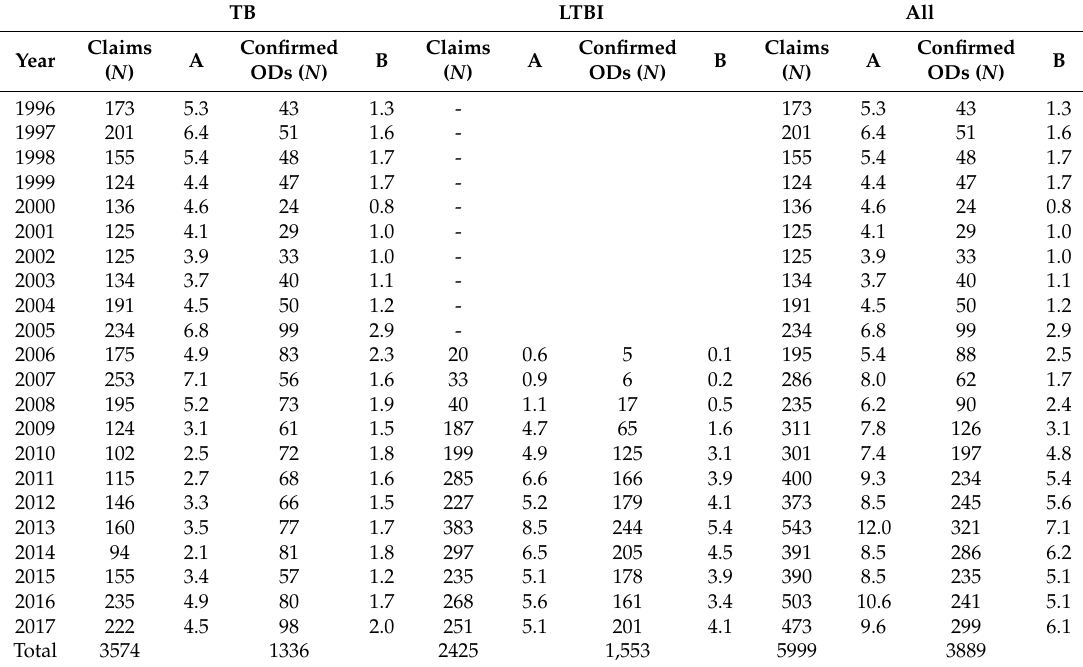
Table 4. Claims and confirmed occupational diseases (ODs) of tuberculosis (TB) and latent TB infection (LTBI) from 1996 to 2017.